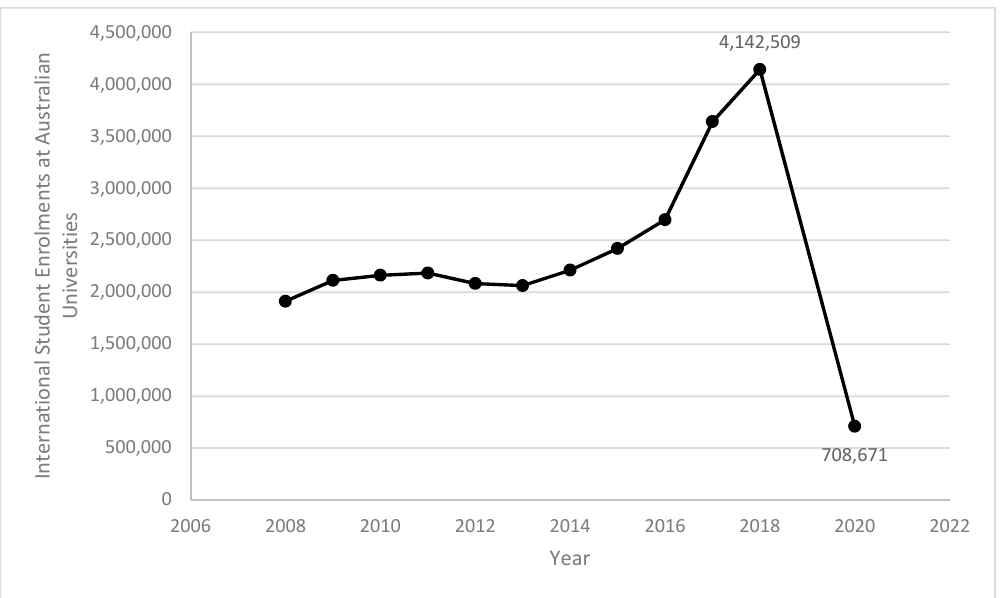
Figure 1. Impact of the novel coronavirus (COVID-19) on International Student Enrolments at Australian Universities. J. Risk Financial Manag. 2020 , 13 , x